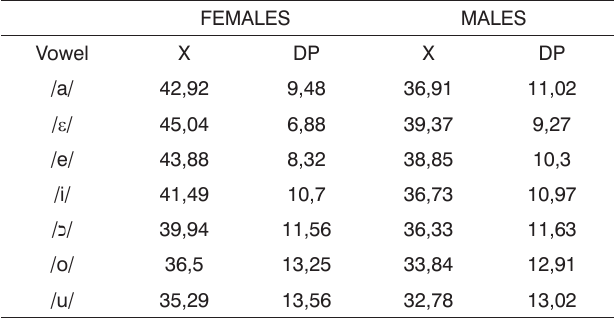
Table 1. Mean harmonic intensity values (db) and their respective standard deviations for each vowel as produced by each gender